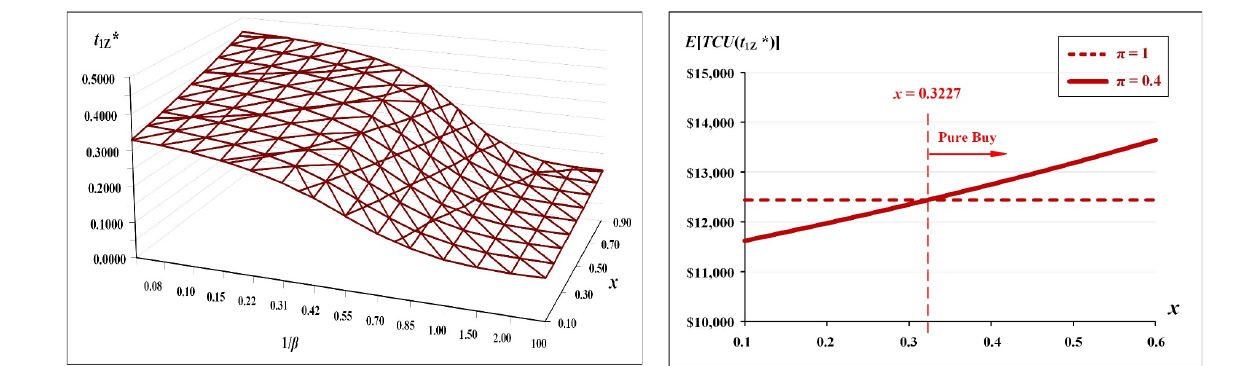
Fig. 9. The collective influence of variations in 1/ β and x on Fig. 10. The critical defective rate x on the ‘make-or-buy’